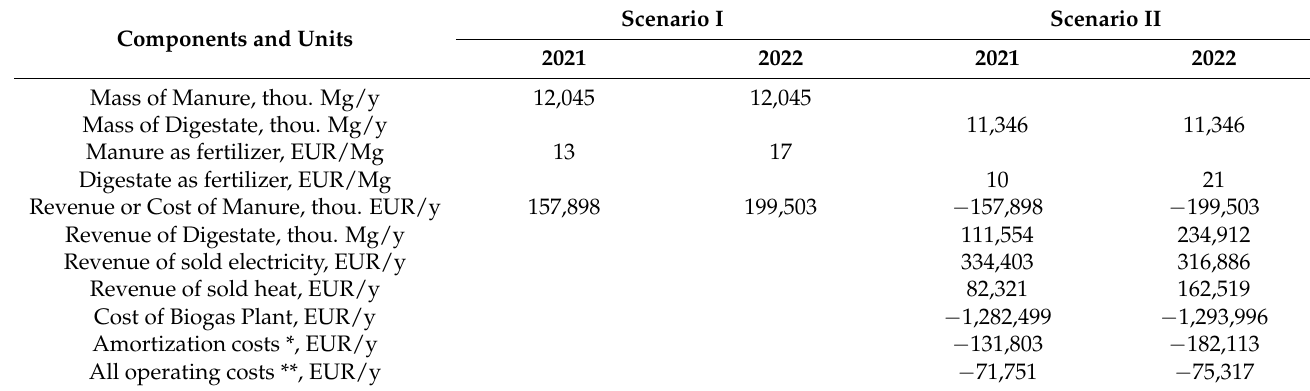
Table 8. Input data for Scenarios I and II in years 2021–2022.